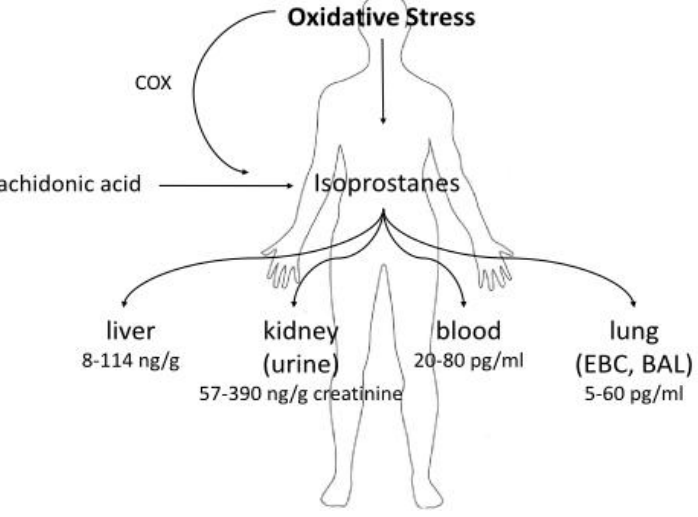
Figure 2. Isoprostane levels in different